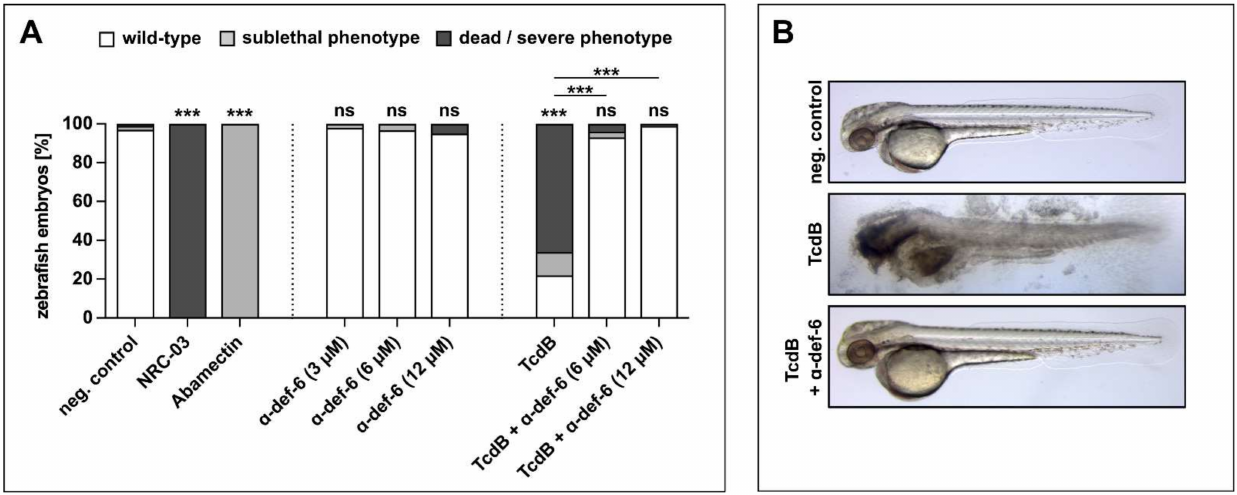
Figure 6. α -def-6 rescues zebrafish embryos from severe TcdB-induced damage and shows no self- toxicity. ( A ) Zebrafish embryos were incubated with TcdB (25 nM), α -def-6 or both. As negative control, embryos were subjected to the respective volume of solvent (PBS). NRC-03 (6 µ M) served as a positive control for cytotoxicity, while Abamectin (3.125 µ M) causes neurotoxicity. After 24 h of